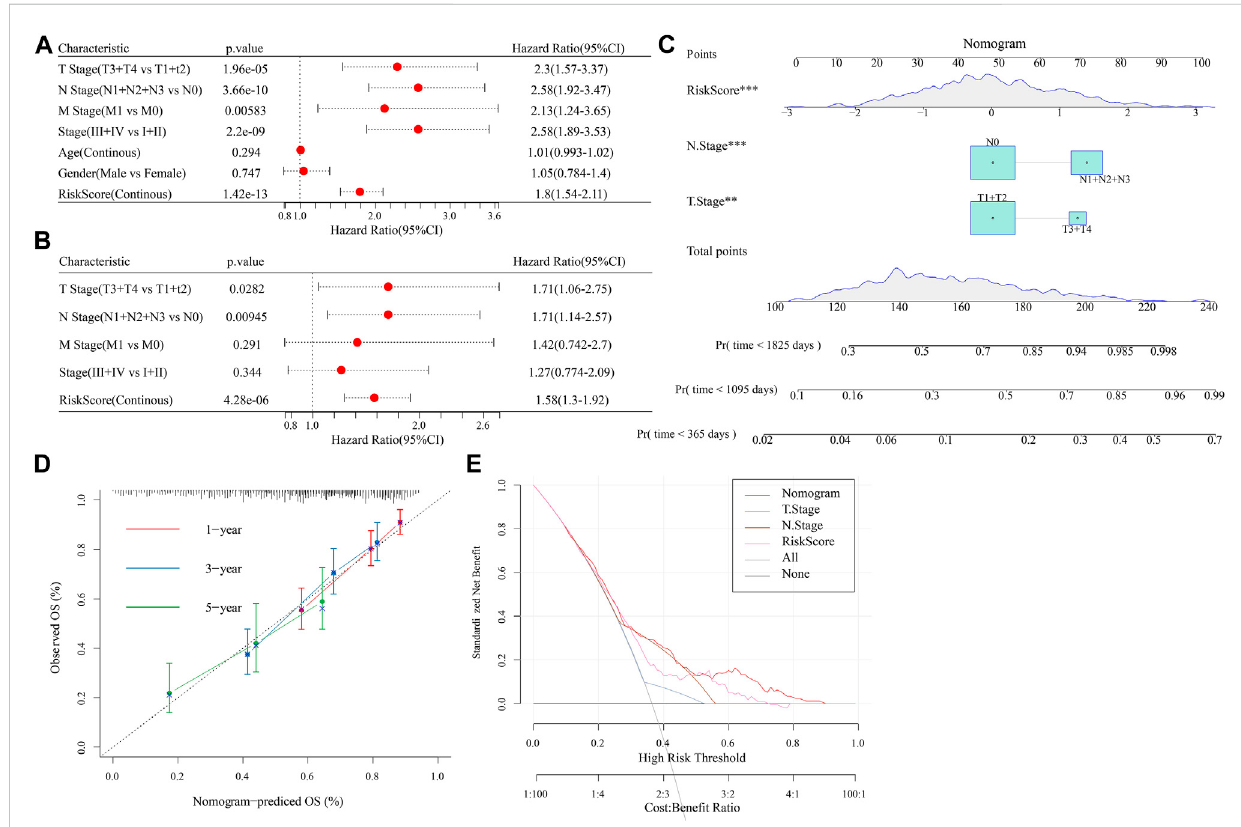
FIGURE 12 Establishmentofnomogram. (A,B) :UnivariateandMultivariateCoxanalysisofRiskScoreandclinicopathologicalcharacteristics; (C) :Thenomogram model; (D) : Calibration curves for 1, 3, and 5 years for the nomogram; (E) : Decision curves for the